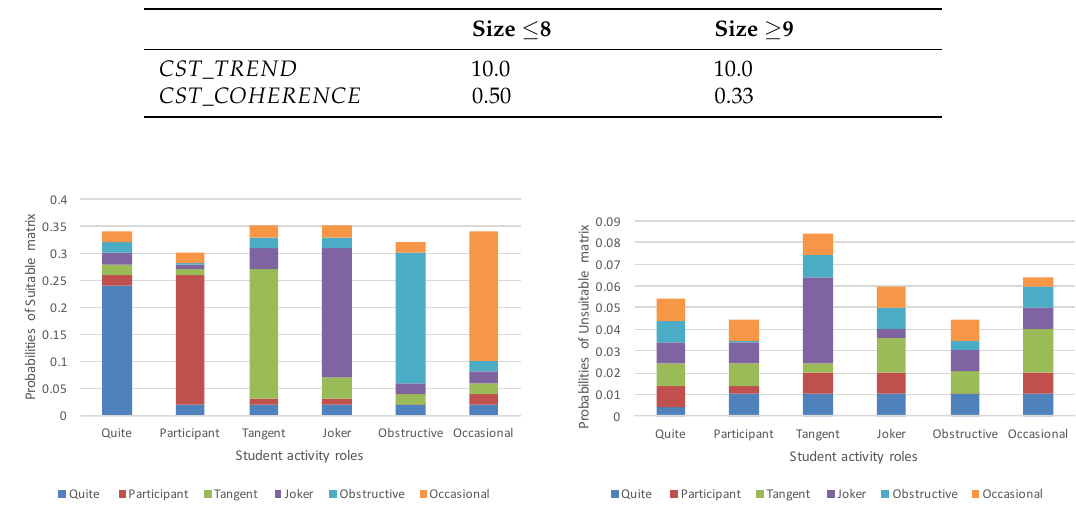
Table 1. Values of constants after the calibration process